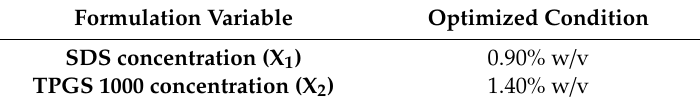
Table 2. Summary of optimized formulation conditions for the manufacture of optimized nano co-crystal